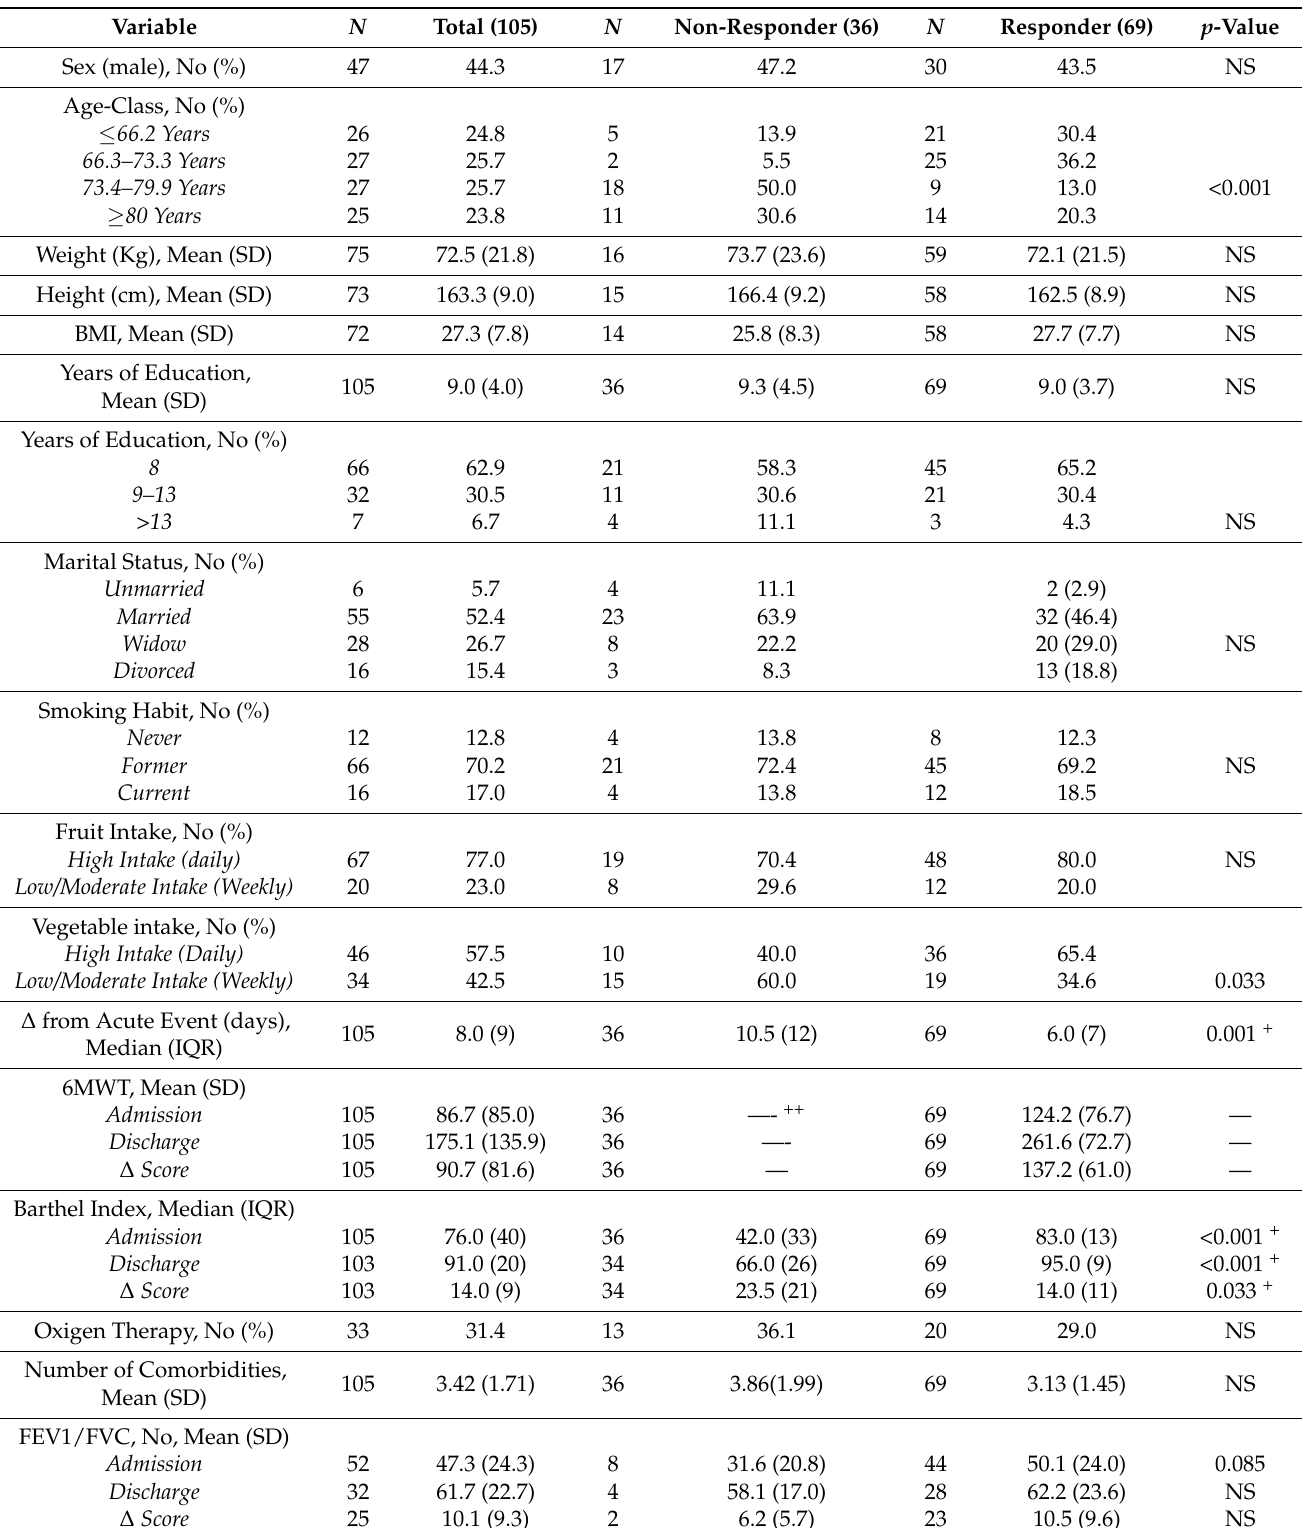
Table 1. Baseline characteristics of COPD patients by response to the